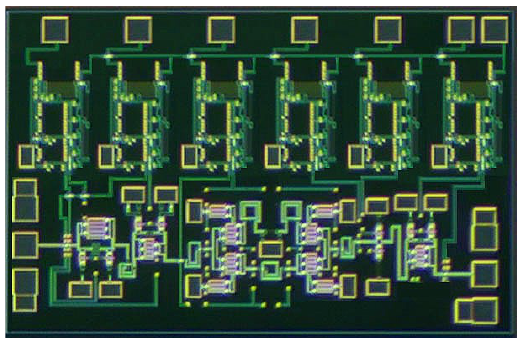
Figure 16. Micrograph of the proposed 6-bit DSA.